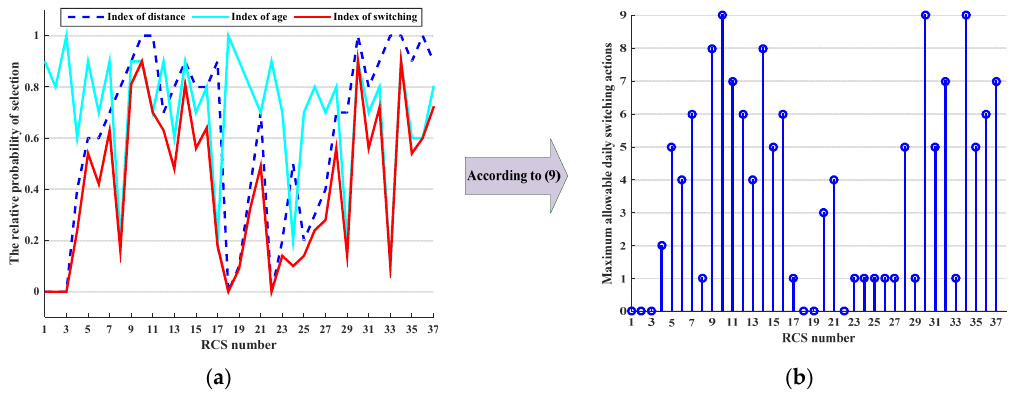
Figure 4. The IEEE 33 ‐ bus radial distribution test system.